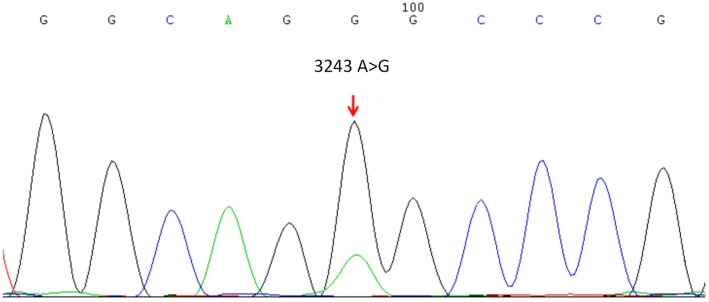
Mitochondrial DNA sequencing revealed the A3243G point mutation in the mitochondrial tRNALeucine gene.